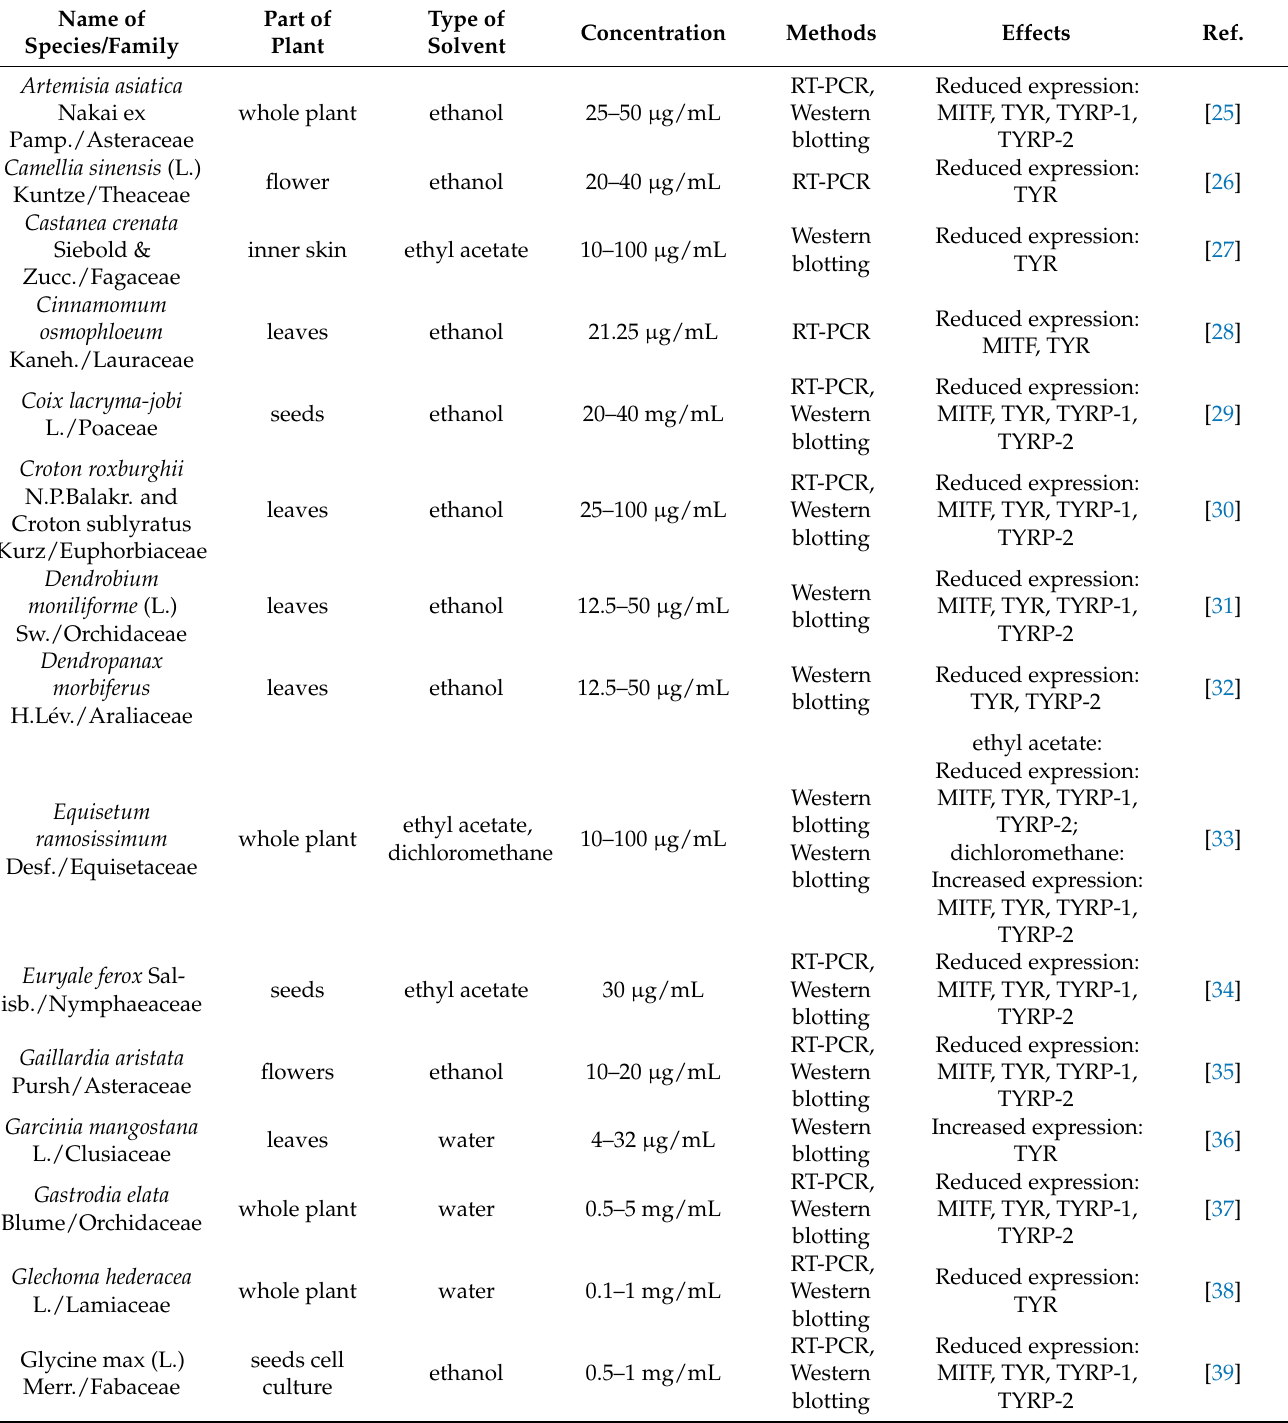
Table 1. Modulation on gene expression related to melanogenesis in B16 melanoma cells by plant extracts without identified